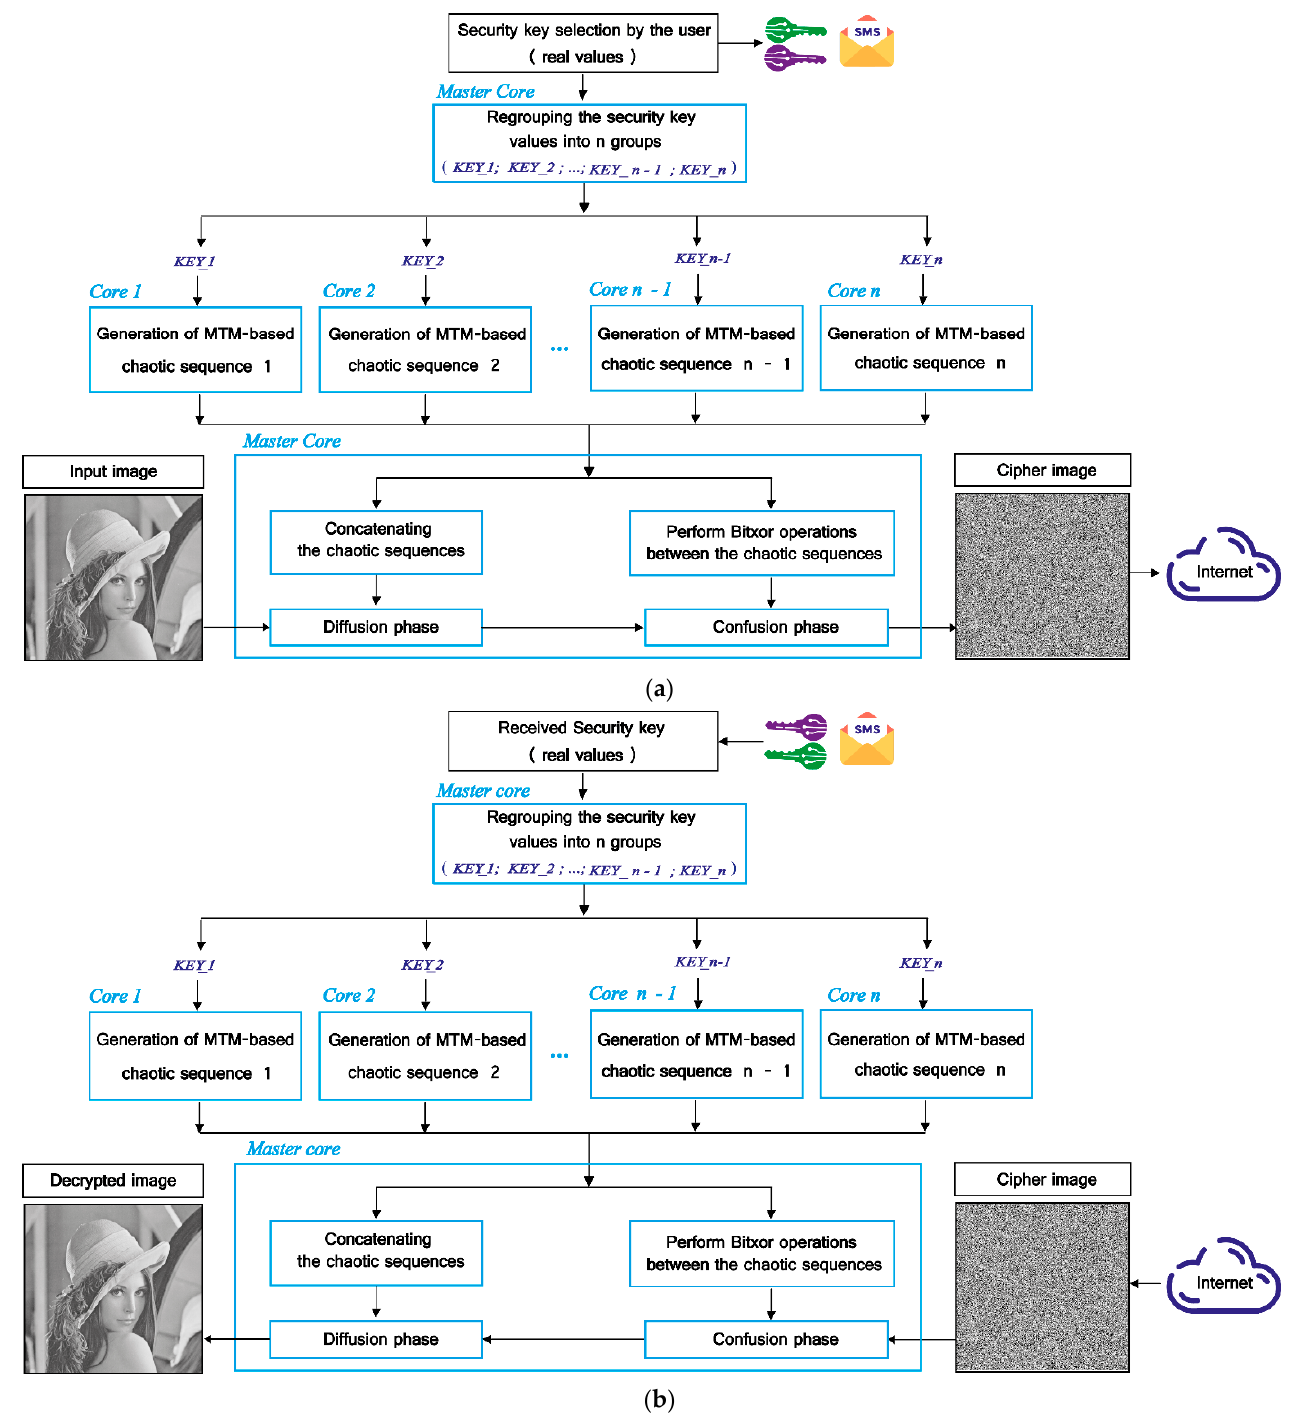
Figure 9. Flowchart the ( a ) encryption and ( b ) the decryption phases of the proposed cryptosystem.